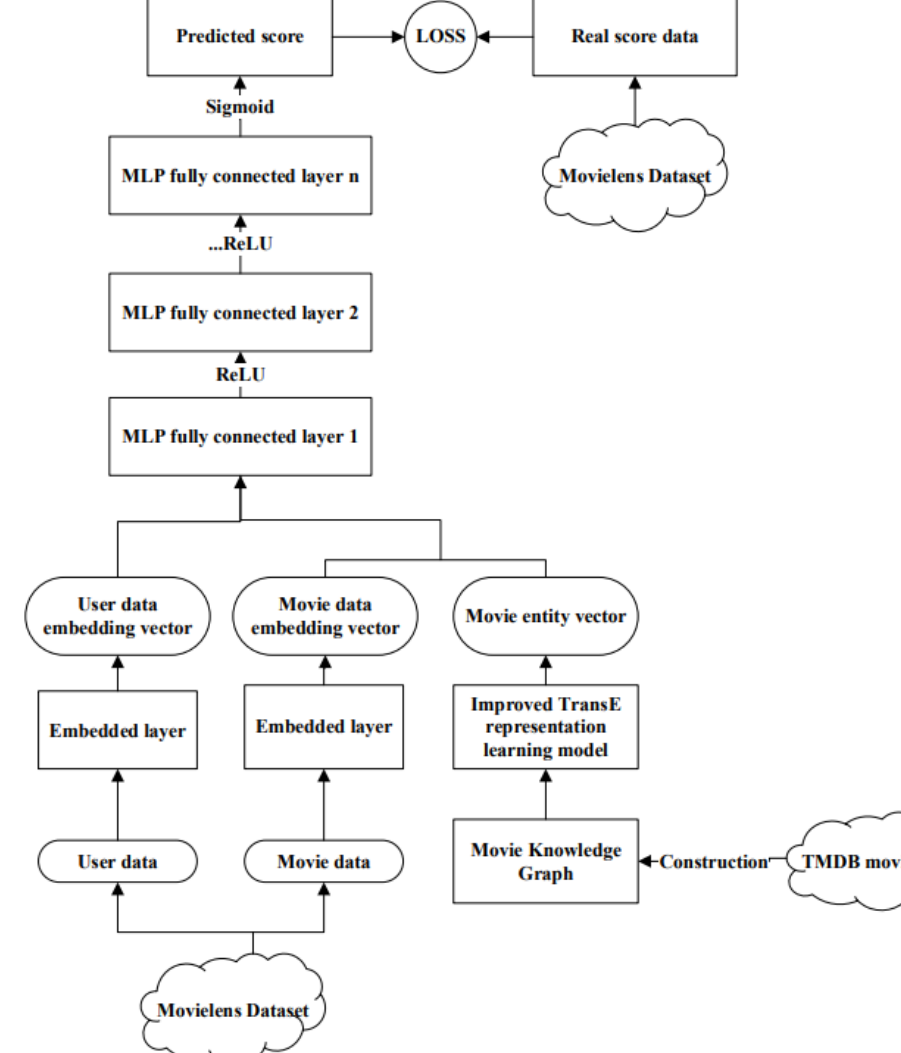
Figure 10. KG-NN model process framework